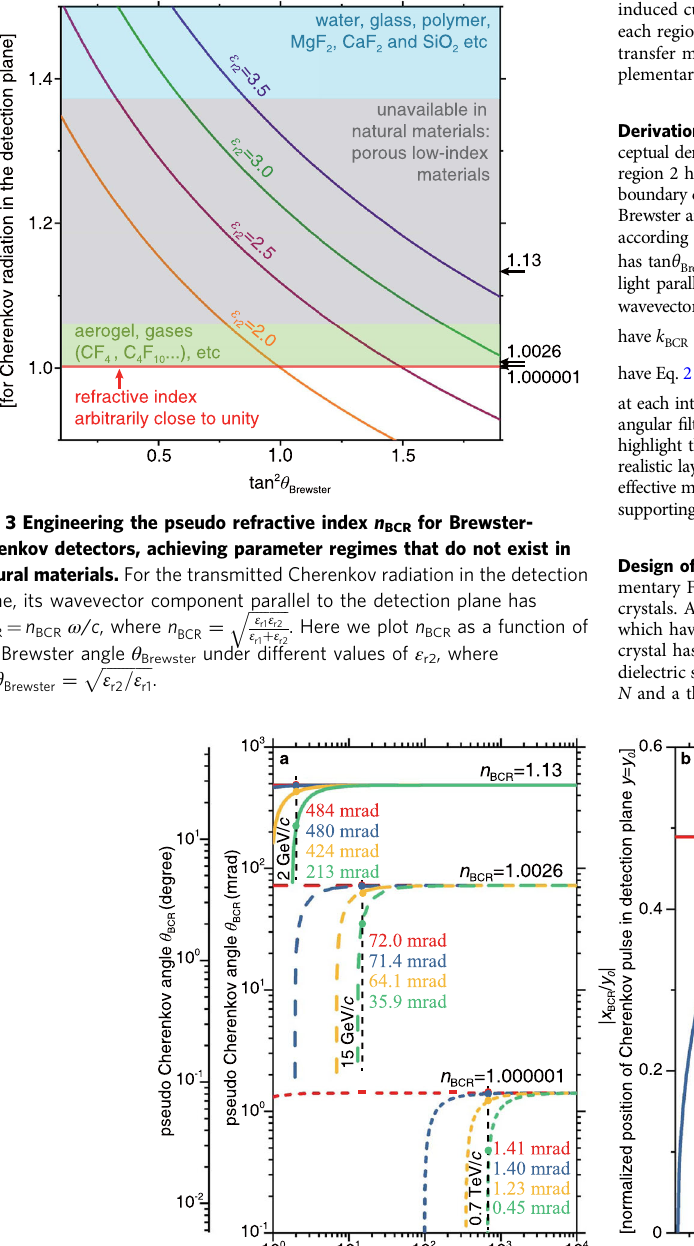
¼ c n BCR v , by transforming the particle velocity to the BCR